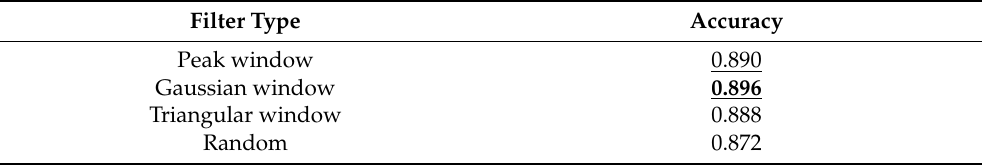
Table 3. Accuracy when each filter was applied. The highest accuracy is underlined and bolded, the second highest is